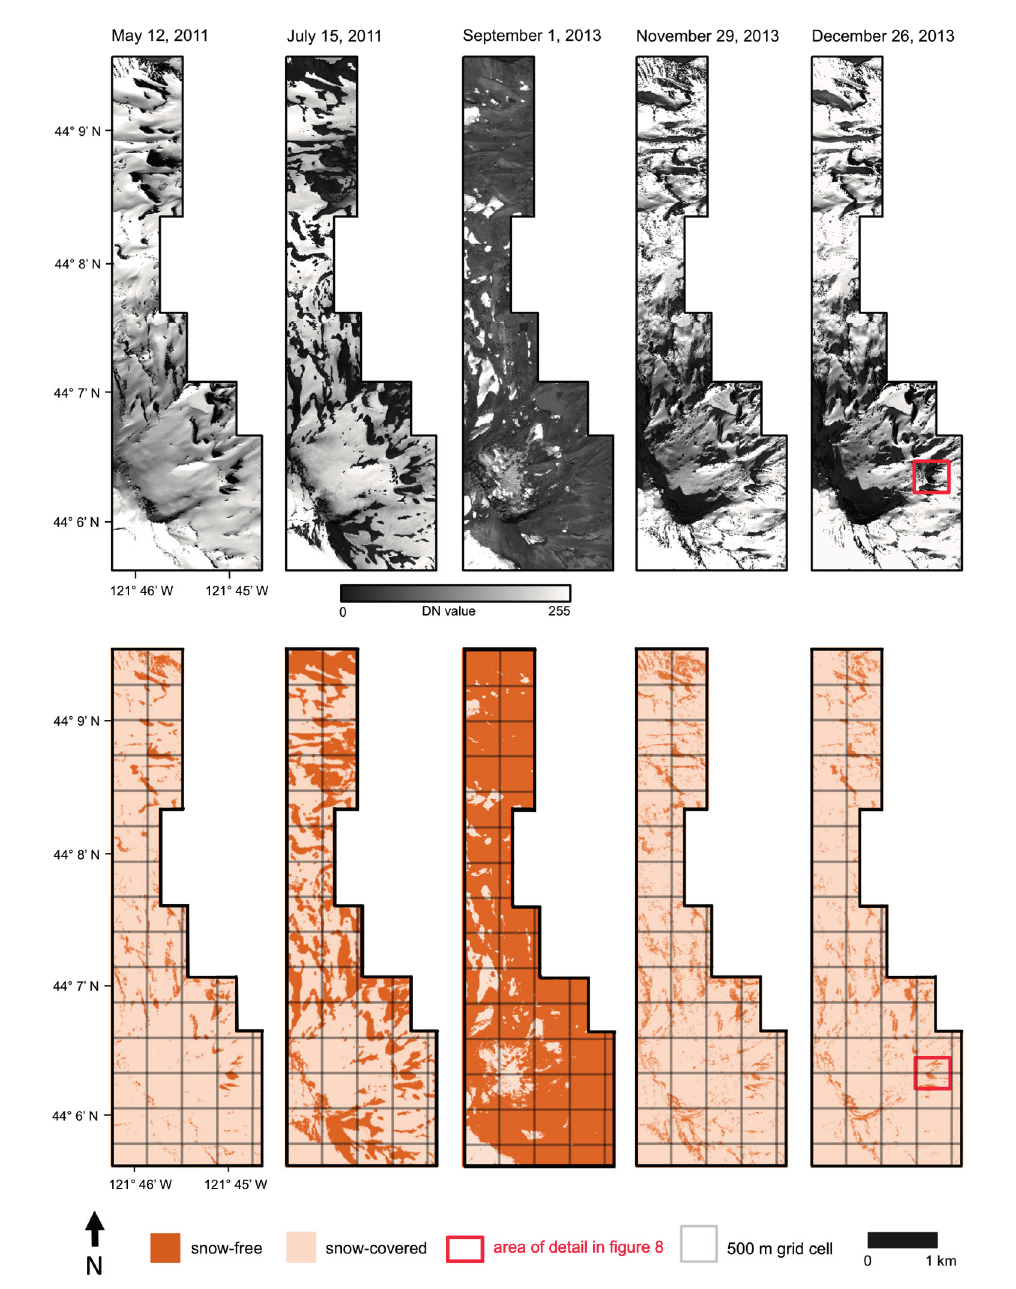
Figure 6. WorldView imagery ( top row ) and high-resolution binary snow-covered area maps ( bottom row ) for the Oregon Cascades ISA. Panchromatic band data is displayed for the 15 July 2011 and 29 November 2013 images, while red band data is displayed for the 12 May 2011, 1 September 2013, and 26 December 2013